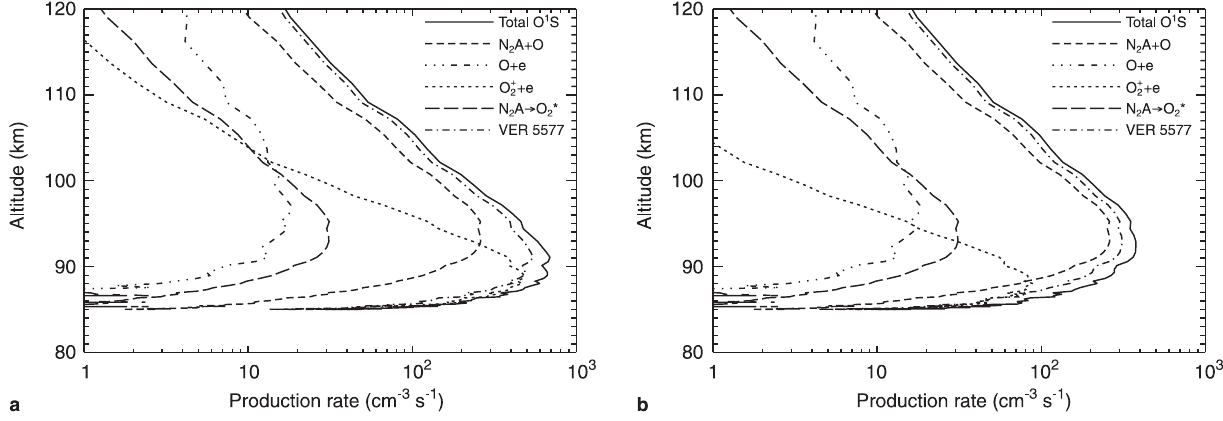
Fig. 1. a O( 1 S) production rates from various sources with normal [NO] and a 50 keV monoenergetic electron spectrum. The resultant volume emission rate (VER) of 5577 A˚ is shown. b Same as a but with high [NO]